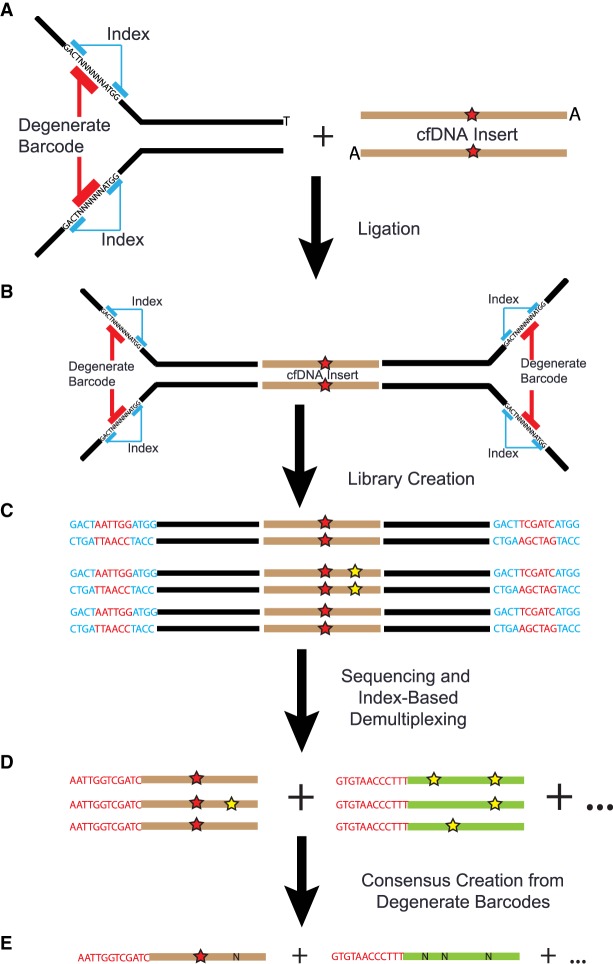
Overview of DIDA adapters, library creation, and consensus creation. (A) Schematic of T-tailed DIDA adapter; regions in black are standard Illumina adapter sequences. (B) Following ligation to A-tailed cell-free DNA (shown with a point mutation, red star) adapters are ligated to each side containing sample-specific index sequence and degenerate barcode. (C) Following library creation and amplification, multiple copies of the same template molecule are created; polymerase errors are shown with a yellow star. Blue sequences are known multiplexing indices, and red are the degenerate barcodes. (D) Following sequencing and demultiplexing, reads are grouped by mapping position and degenerate sequence. Brown and green represent copies of two different input molecules. (E) Reads are collapsed into a single-strand consensus sequence (SSCS), using mapping position and degenerate sequence; real mutations are retained, whereas polymerase errors are replaced by Ns.